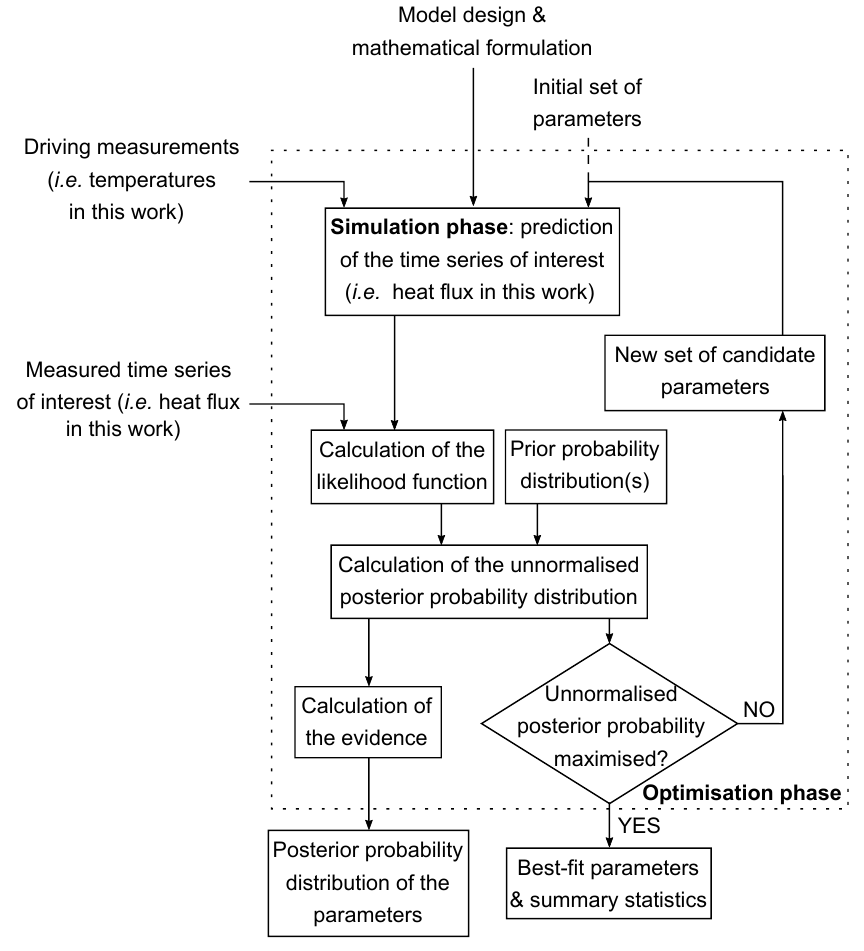
Flow chart of the dynamic Bayesian method developed for the estimation of the thermophysical properties of building elements with maximum a posteriori optimisation. The Markov chain Monte Carlo approach works in a similar fashion, with the following differences: (1) at each iteration a new set of candidate parameters is proposed based on the Metropolis–Hastings algorithms; and (2) the evidence is based on the reciprocal importance sampling